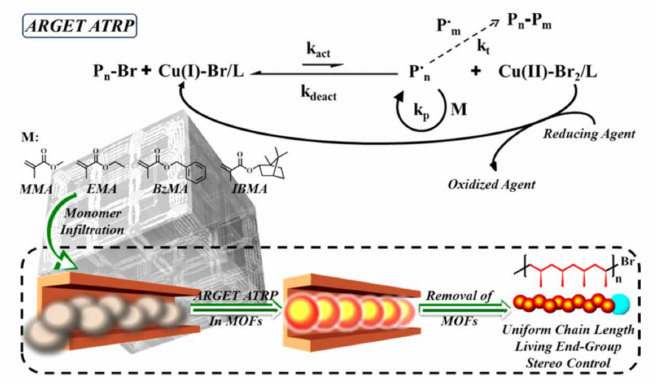
Figure 14. Scheme showing the ARGET ATRP in the nanochannel of MOF for the synthesis of well-defined polymers [91]. Copyright 2018, American Chemical